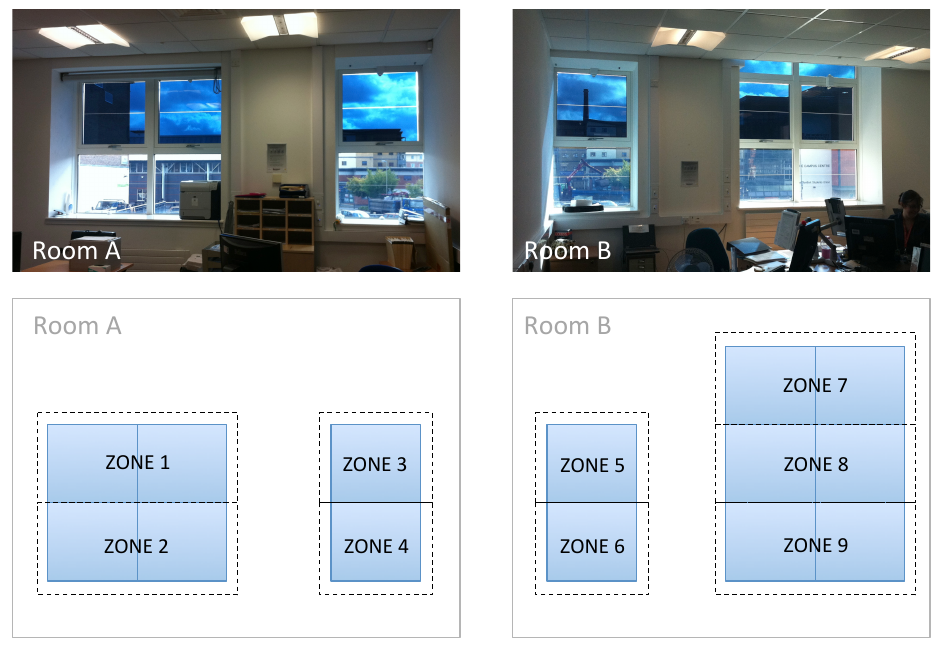
Figure 1. Photographs of the electrochromic (EC) windows in the two offices with corresponding schematics showing the control